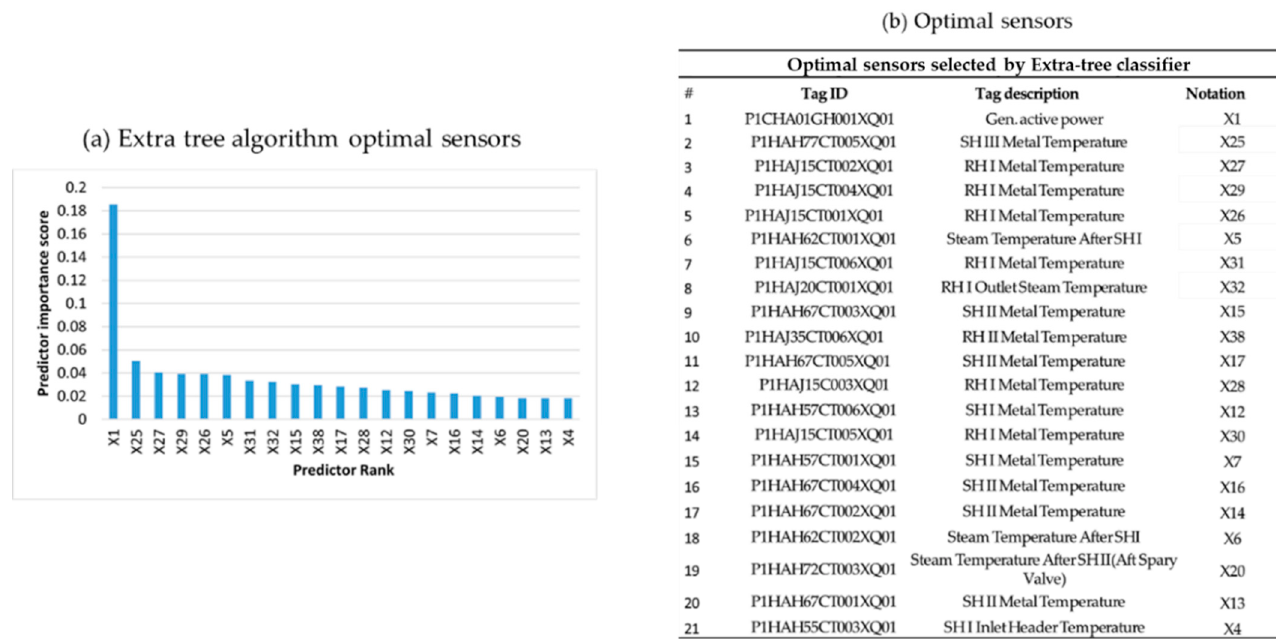
Figure 9. ( a ) mRMR algorithm selected sensors; ( b ) optimal sensors selected by mRMR algorithm.